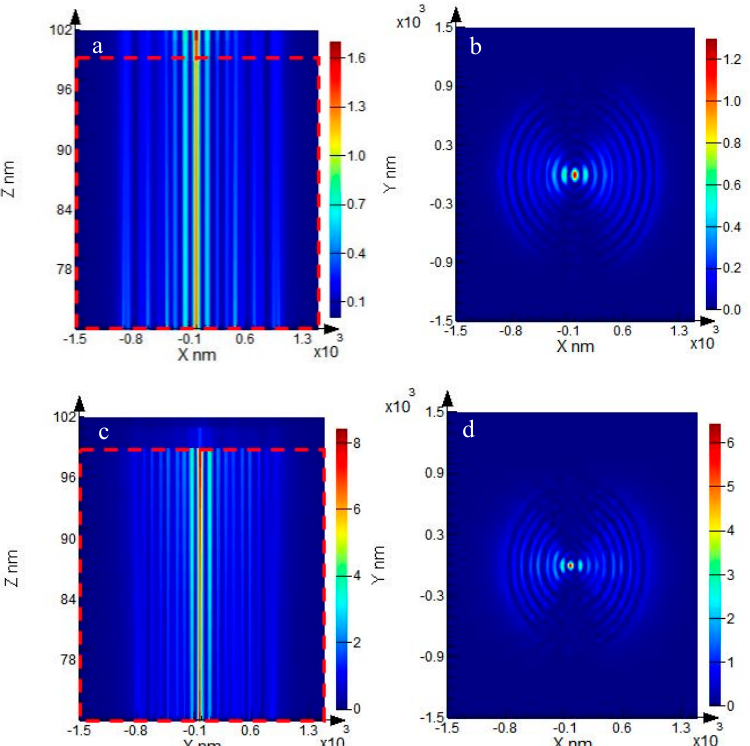
Figure 6. Results from the FDTD Solutions software, ( a ) with no metal reflector and ( c ) with the aluminum reflector. ( b ) and ( d ) are the cross-section of ( a ) and ( c ) at 85 nm, respectively.